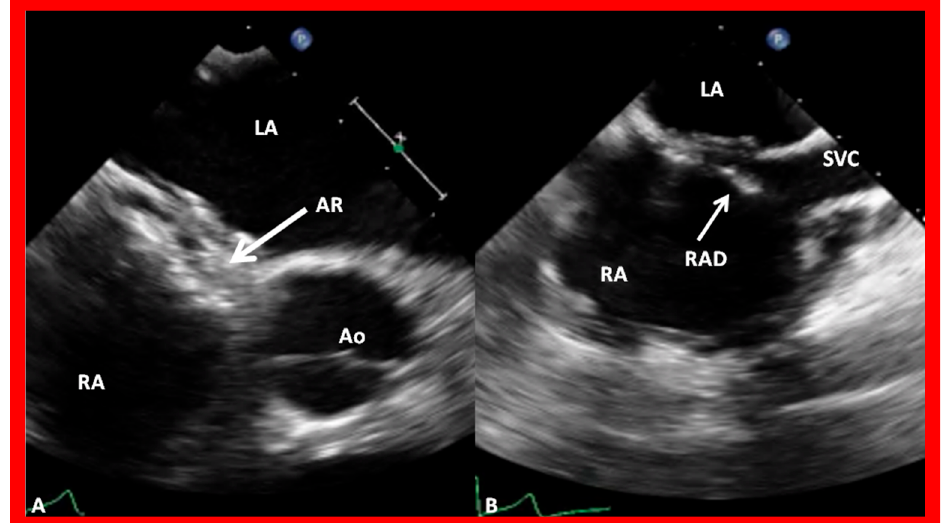
Figure 34. Transesophageal echocardiographic images of the GORE ® CARDIOFORM ASD Occluder device after its deployment in two different projections. In the short-axis view ( A ), the aortic rim (AR) (arrow in ( A )) is visualized sandwiched in-between the right and left atrial discs. In the bi-caval view ( B ) note that there was a little splaying of the upper part of the right atrial disc (RAD). Ao, aorta; LA, left atrium; RA, right atrium; SVC, superior vena cava. Reproduced from reference [37].